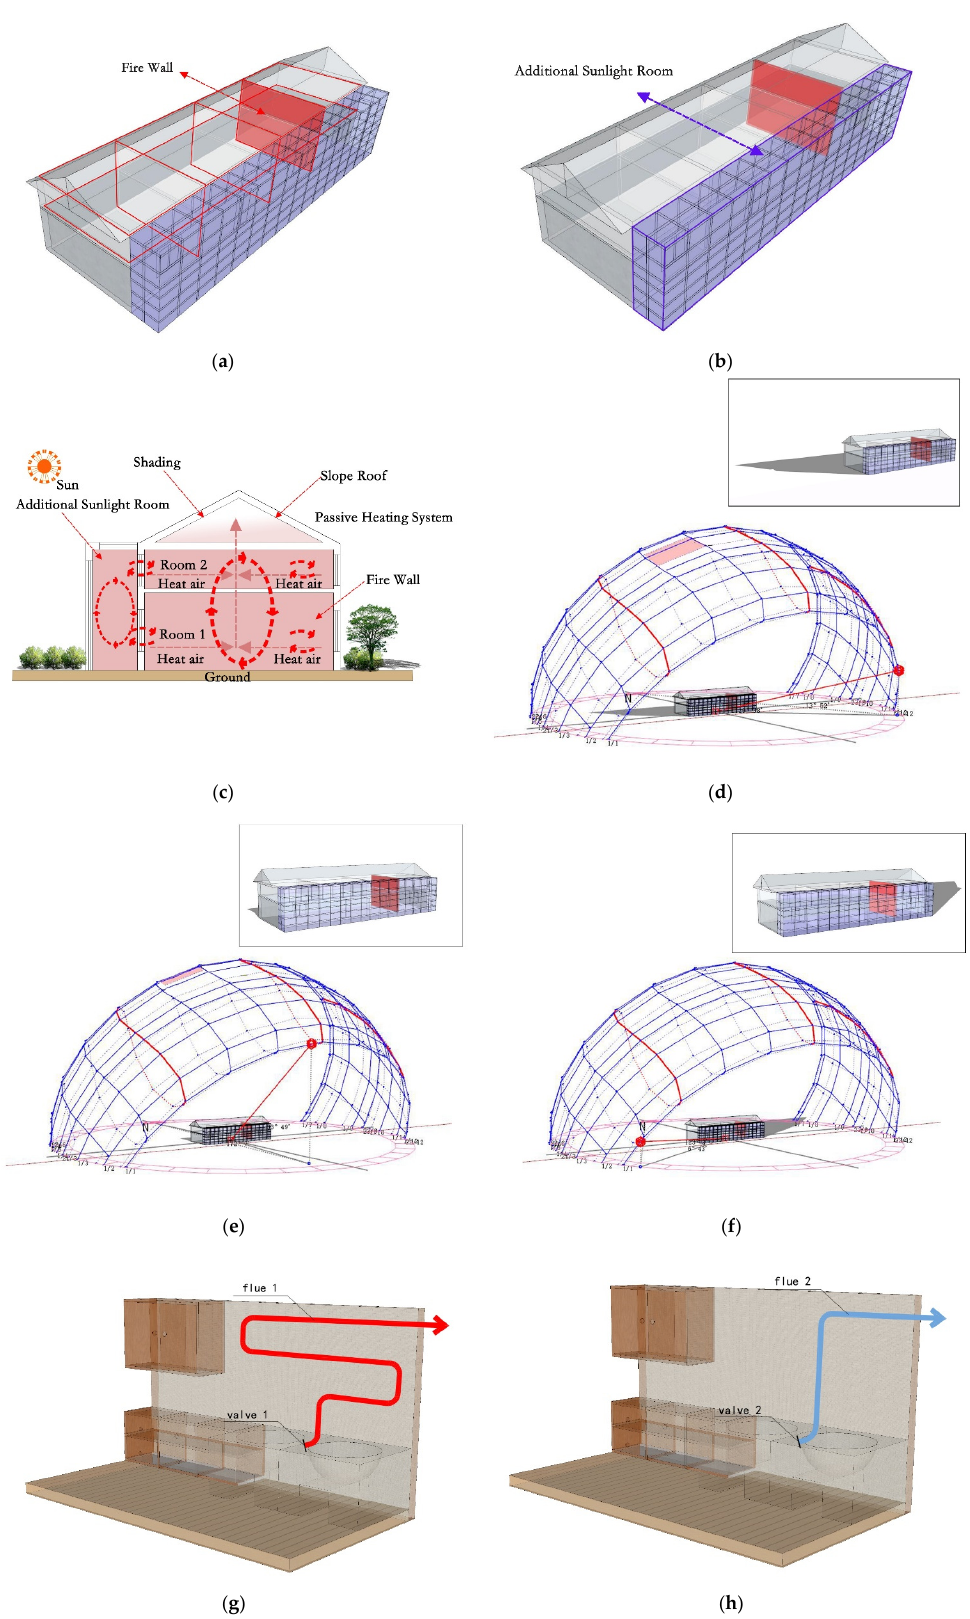
Figure 3. ( a ) The location of the firewall. ( b ) The location of additional sunlight. ( c ) Heat transfer effect picture. ( d ) Sunshine conditions in winter at 8:00 a.m. ( e ) Sunshine conditions in winter at 12 a.m. ( f ) Sunshine conditions in winter at 5:00 p.m. ( g ) Firewall system design in winter. ( h ) Firewall system design in summer.